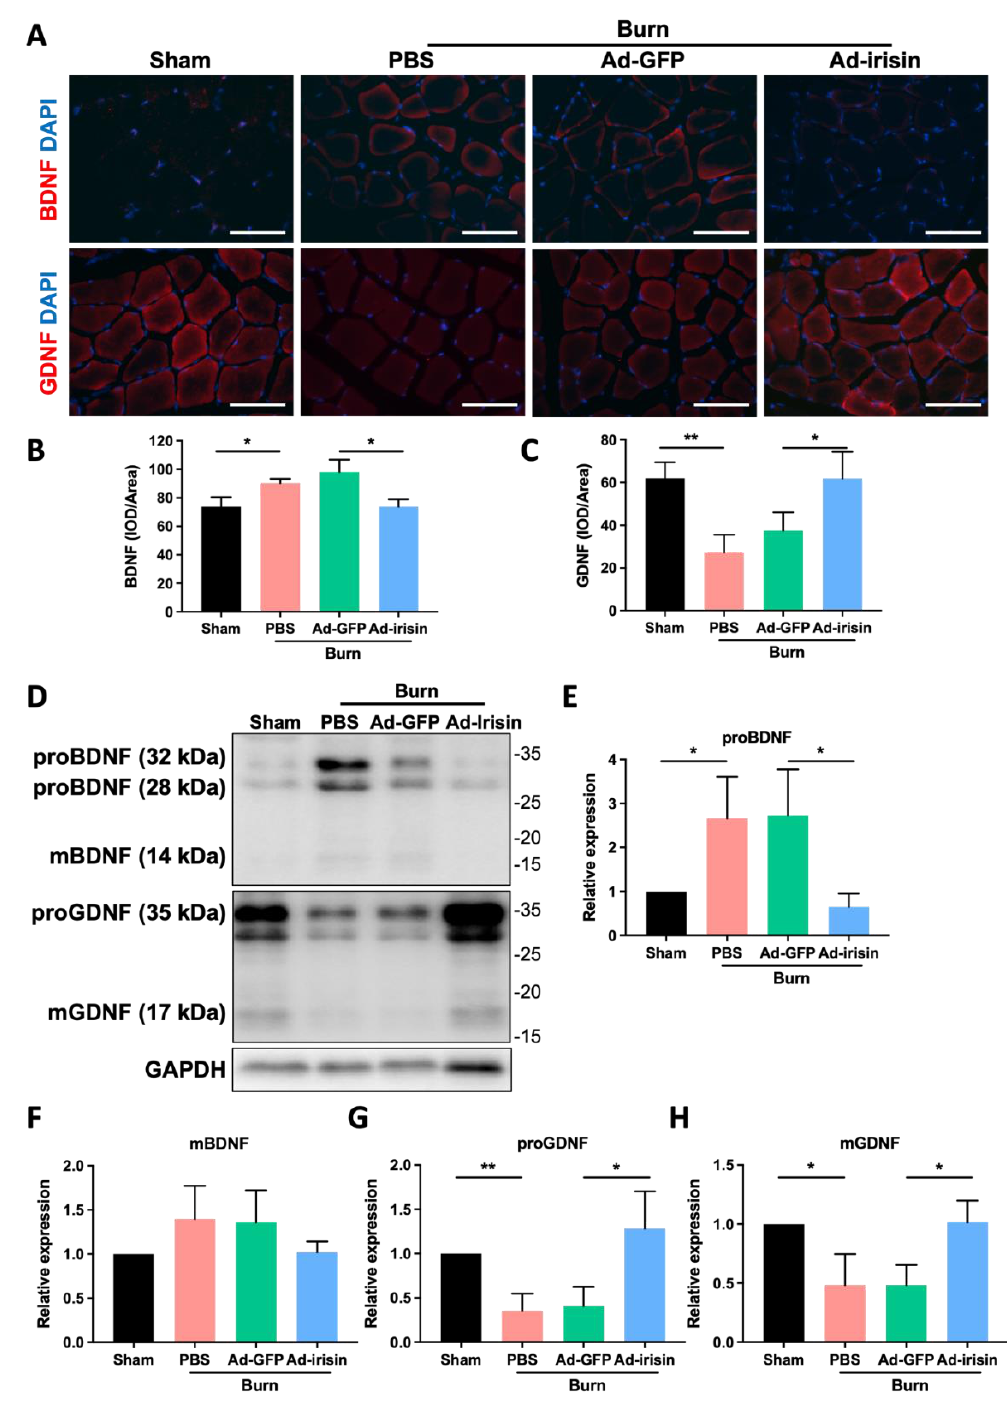
Figure 6. Spinal irisin gene delivery modulated BDNF and GDNF expression in ipsilateral gastrocnemius muscle after burn injury. ( A ) Immunofluorescence staining of BDNF and GDNF in ipsilateral gastrocnemius muscle in the fourth week after burn injury. DAPI was used to visualize the nucleus. ( B , C ) Representative bar graphs illustrating averaged optical intensity of BDNF and GDNF. Error bars represent standard deviations (SDs). * p < 0.05, ** p < 0.01, unpaired t-test. ( D ) Tissue of ipsilateral gastrocnemius muscle in the fourth week after burn injury was subjected to immunoblotting analysis. ( E – H ) Representative bar graph illustrating normalized expression of proBDNF, mBDNF, proGDNF, and mGDNF, with GAPDH as an internal control, in ipsilateral gastrocnemius muscle in the fourth week after burn injury. Error bars represent SDs. * p < 0.05, ** p < 0.01, unpaired t-test.